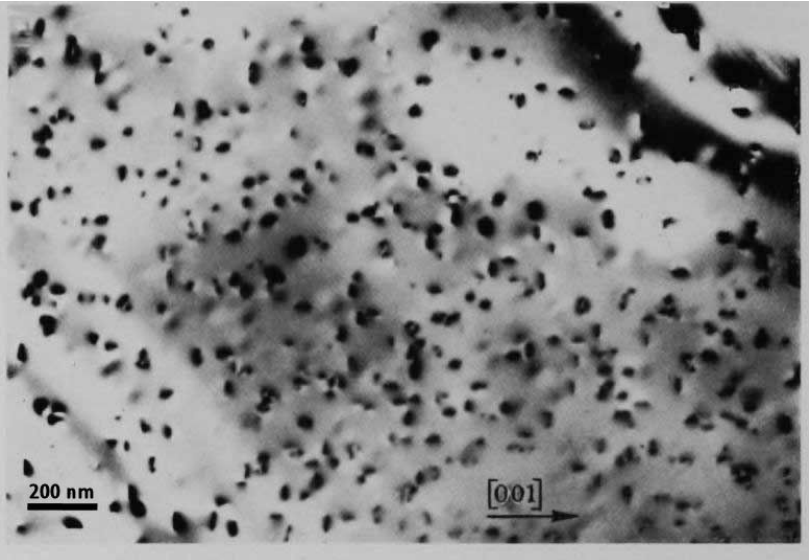
Figure 3. One of the first TEM images of platelets in type Ia diamond, from a 1962 paper by Evans & Phaal. Reproduced with permission from [43]. Royal Society, 1962.